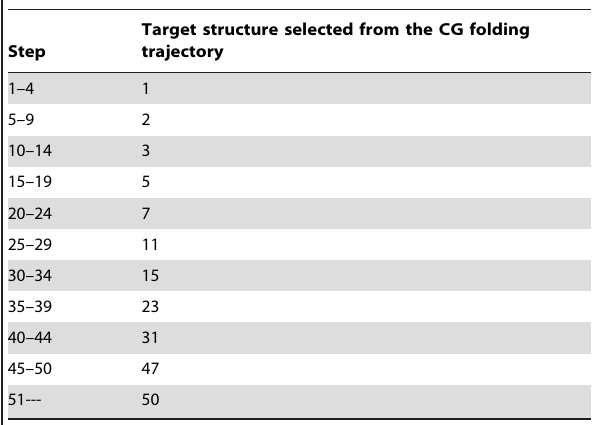
Table 1. Evolution of targeted CG structures.